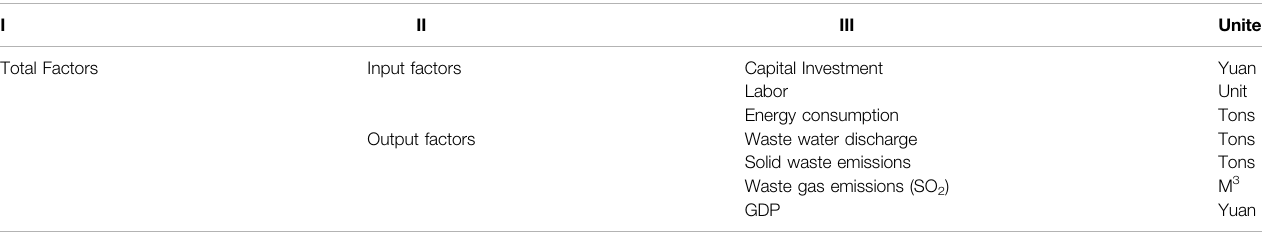
TABLE 1 | The composition of total factors